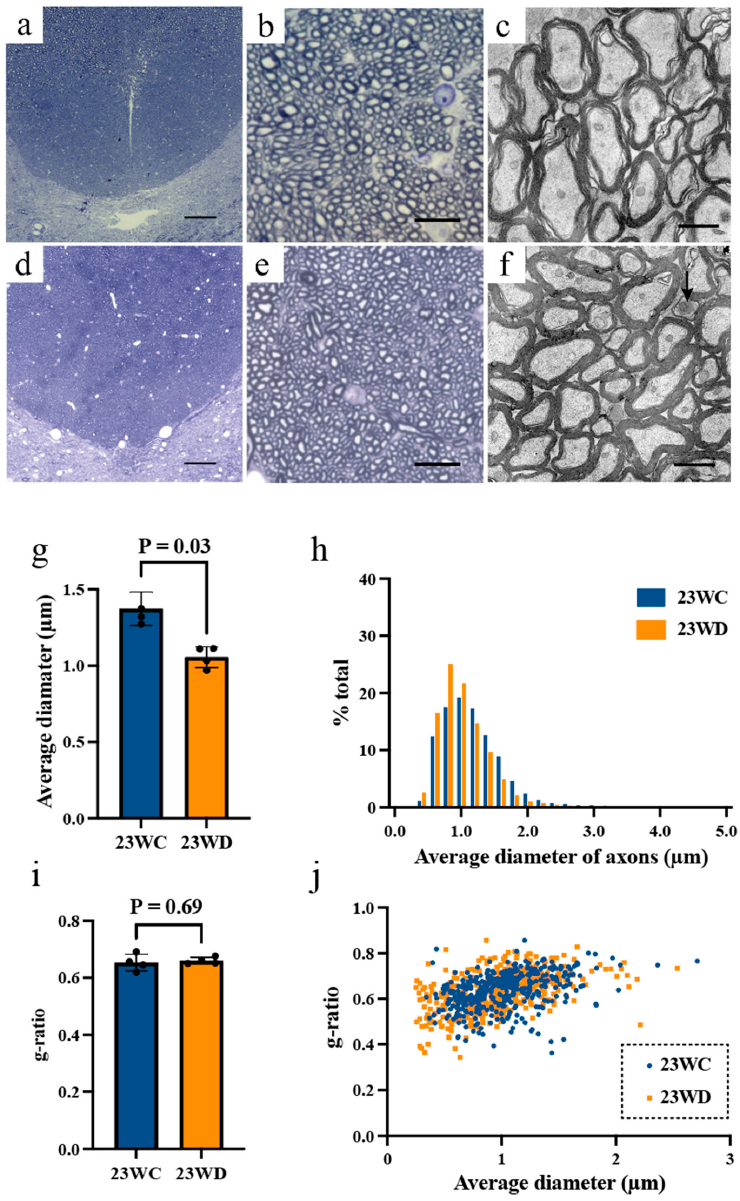
Figure 3. ( a , b ) Optical micrographs of the BDF in the cervical spinal cord ( a ) and BDF fibers ( b ) in 23WC. ( c ) Electron micrographs of BDF fibers in 23WC. ( d , e ) Optical micrographs of the BDF of the cervical spinal cord ( d ) and BDF fibers ( e ) in 23WD. Evidently, the BDF fibers are thinner in 23WD than 23WC. ( f ) Electron micrographs of BDF fibers in 23WD. The arrow indicates a degenerating axon. No changes in the myelin sheath were observed, and degenerating axons were only rarely observed. The scale bar indicates 100 μ m ( a , d ), 10 μ m ( b , e ), and 1 μ m ( c , f ). ( g ) Average diameter of BDF axons. The size of axons was significantly smaller in 23WD ( p < 0.05, Mann-Whitney U test). ( h ) Size distribution of BDF axons in the cervical spinal cord in 23WC (n = 12,256 axons) and 23WD (n = 10,673 axons). The Kolmogorov–Smirnov test revealed a significant ( p < 0.0001) between-group difference. ( i ) g-ratio of BDF fibers. There was no significant difference between the two groups ( p < 0.05, Mann–Whitney U test). ( j ) The relationship between axonal diameter and the g-ratio in 23WC (n = 420 fibers) and 23WD (n = 431 fibers). There was no difference between the two groups. Abbreviations: BDF, base of the dorsal funiculus; 23WC, control animals at 23 weeks after sham diabetes induction; 23WD, diabetic animals at 23 weeks after diabetes